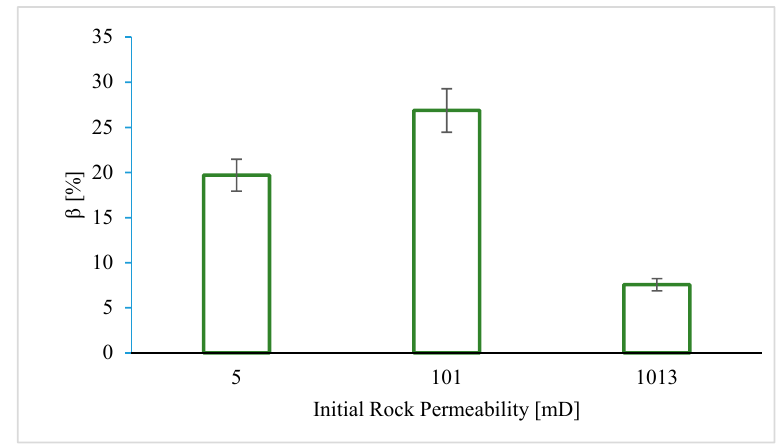
Figure 7. The influence of initial rock permeability on injectivity impairment induced by mineral dissolution. There was no obvious correlation between injectivity impairment and initial rock permeability.